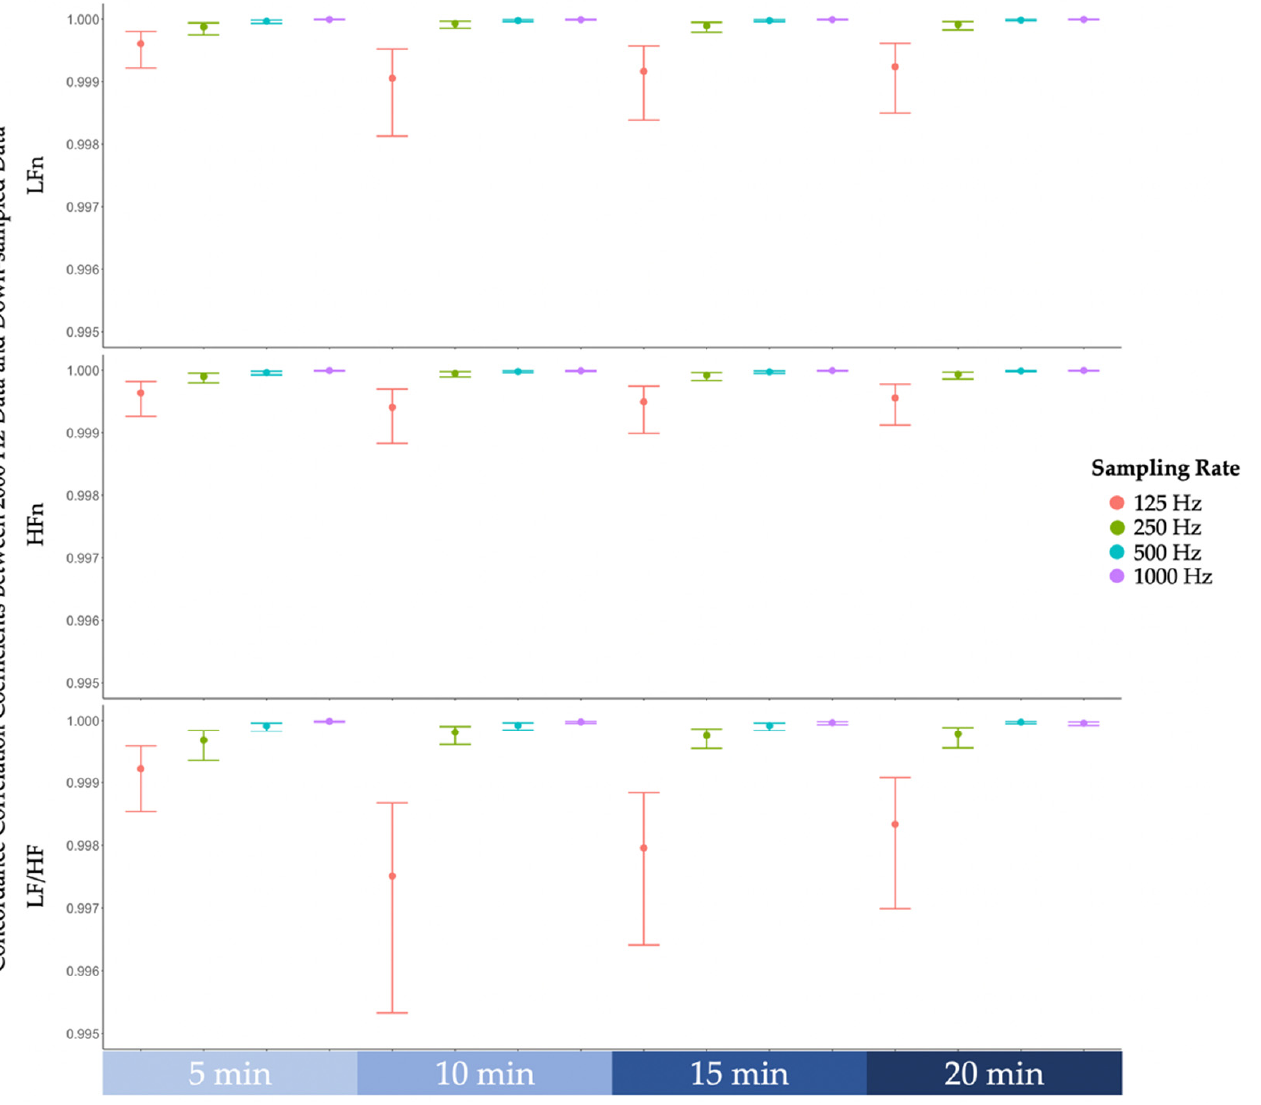
Figure 4. The concordance correlation coefficients between frequency-domain features derived from the original 2000 Hz data and features derived from down-sampled data (i.e., 1000 Hz, 500 Hz, 250 Hz, 125 Hz). From top to bottom, concordance correlation coefficients of low-frequency power normalised (LFn), high-frequency power normalised (HFn), and the ratio of low-frequency power to high-frequency power (LF/HF). Note that the error bars represent 99% confidence intervals.